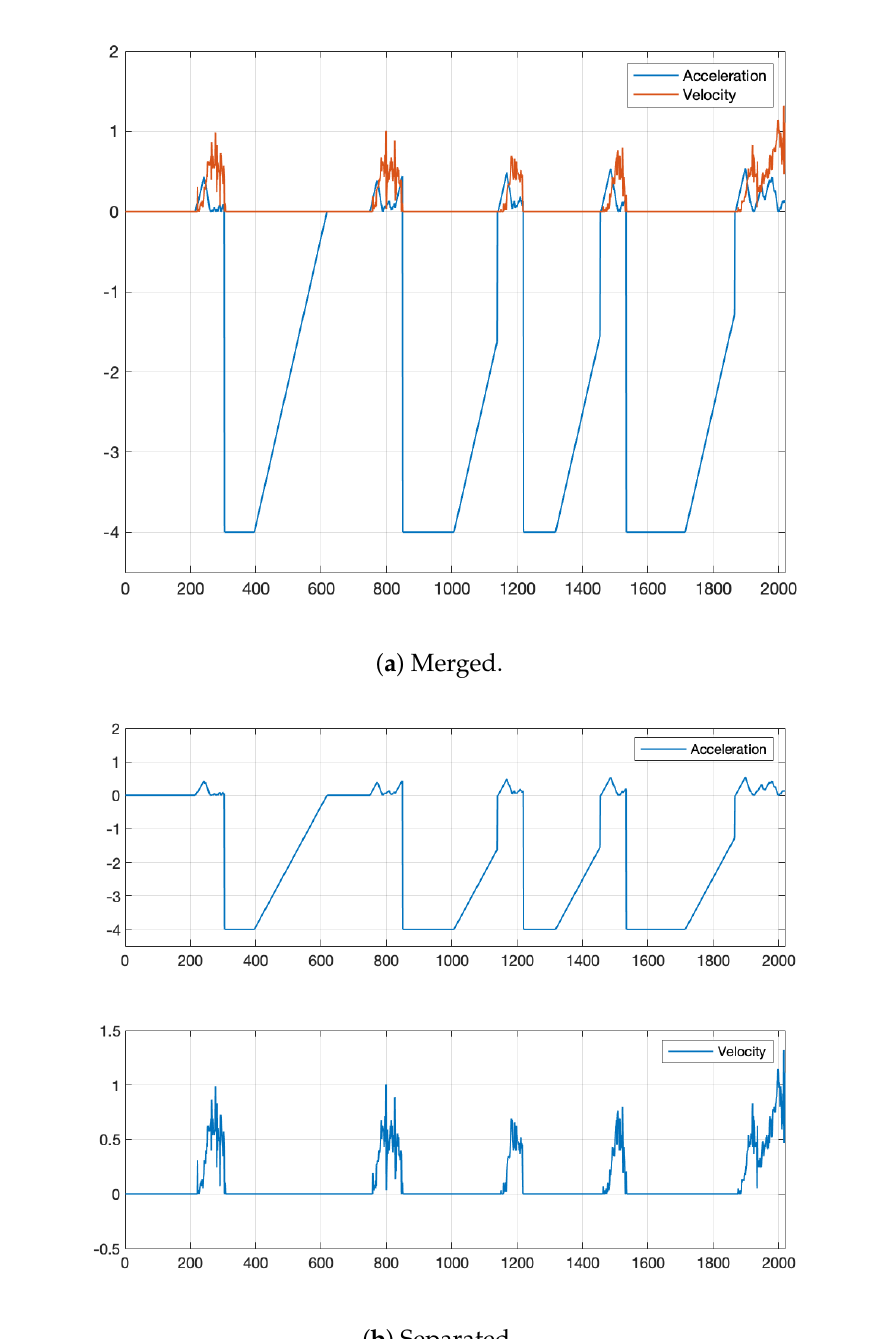
Figure 23. Calculated accelerations and actual